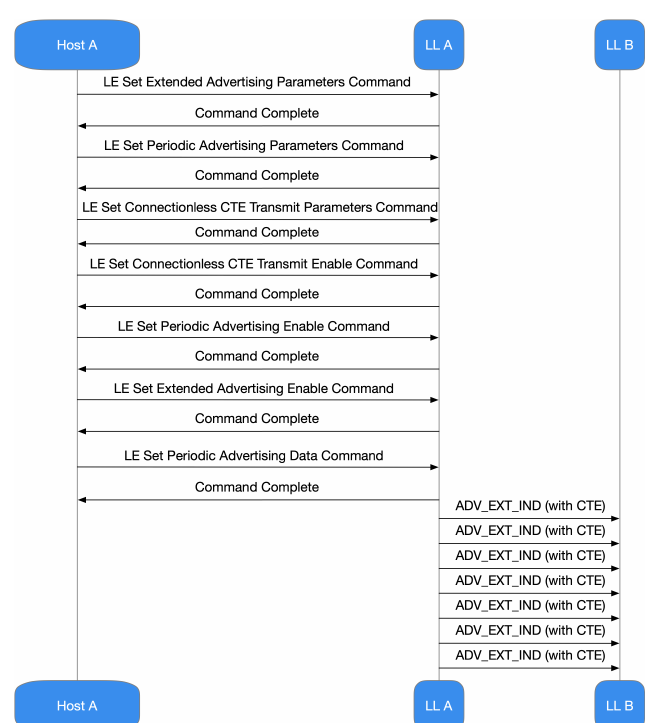
Figure 12. Actions concerning controller start-up delivered by the appliance for connectionless situations, i.e., those commonly practiced by